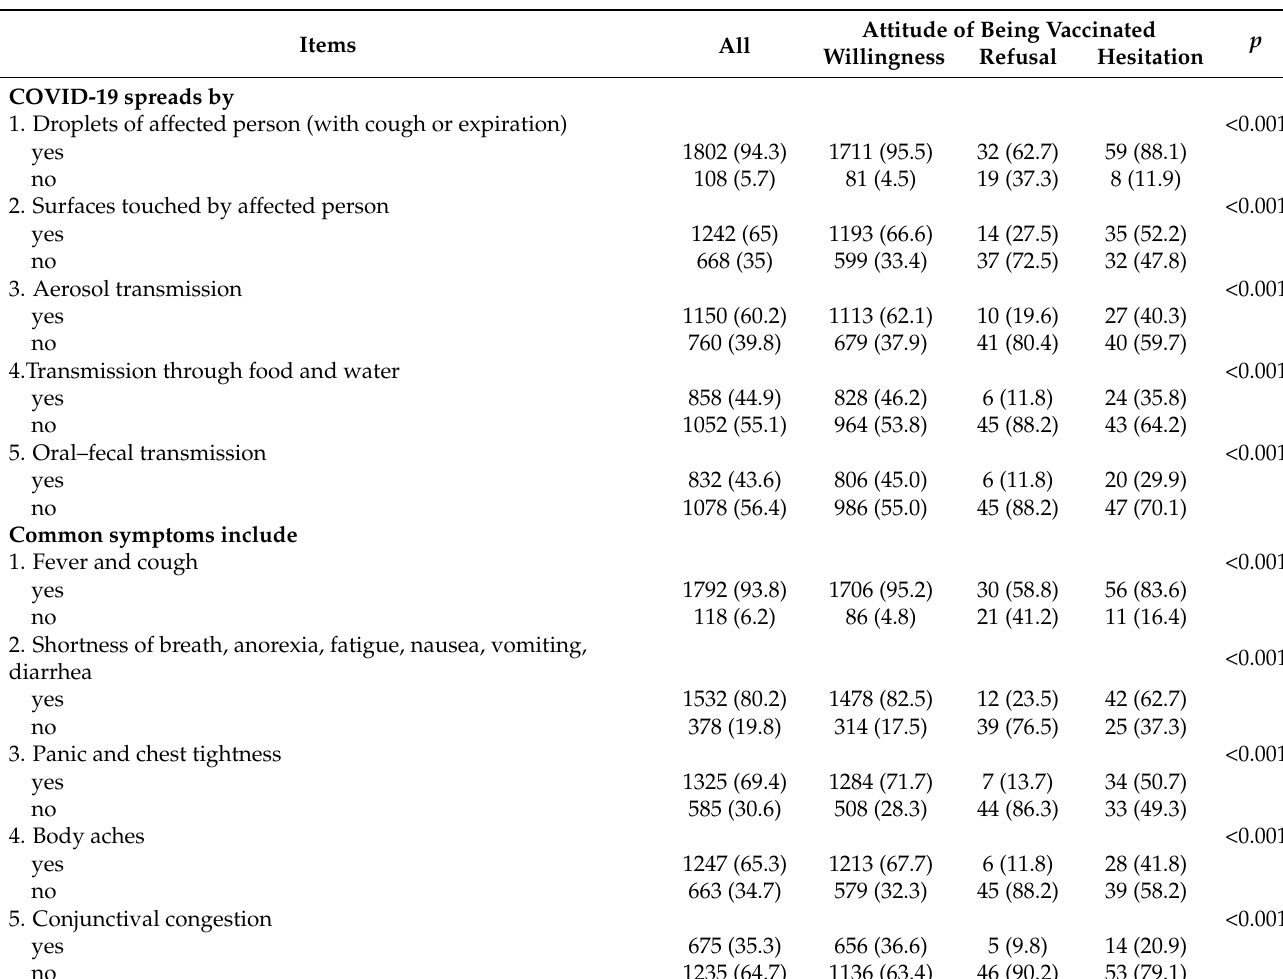
Table 2. The differences between willing, unwilling, and hesitant attitudes in relation to knowledge of